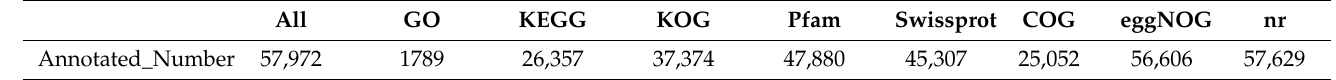
Table 3. Annotation results of transcripts in F01 libraries based on different